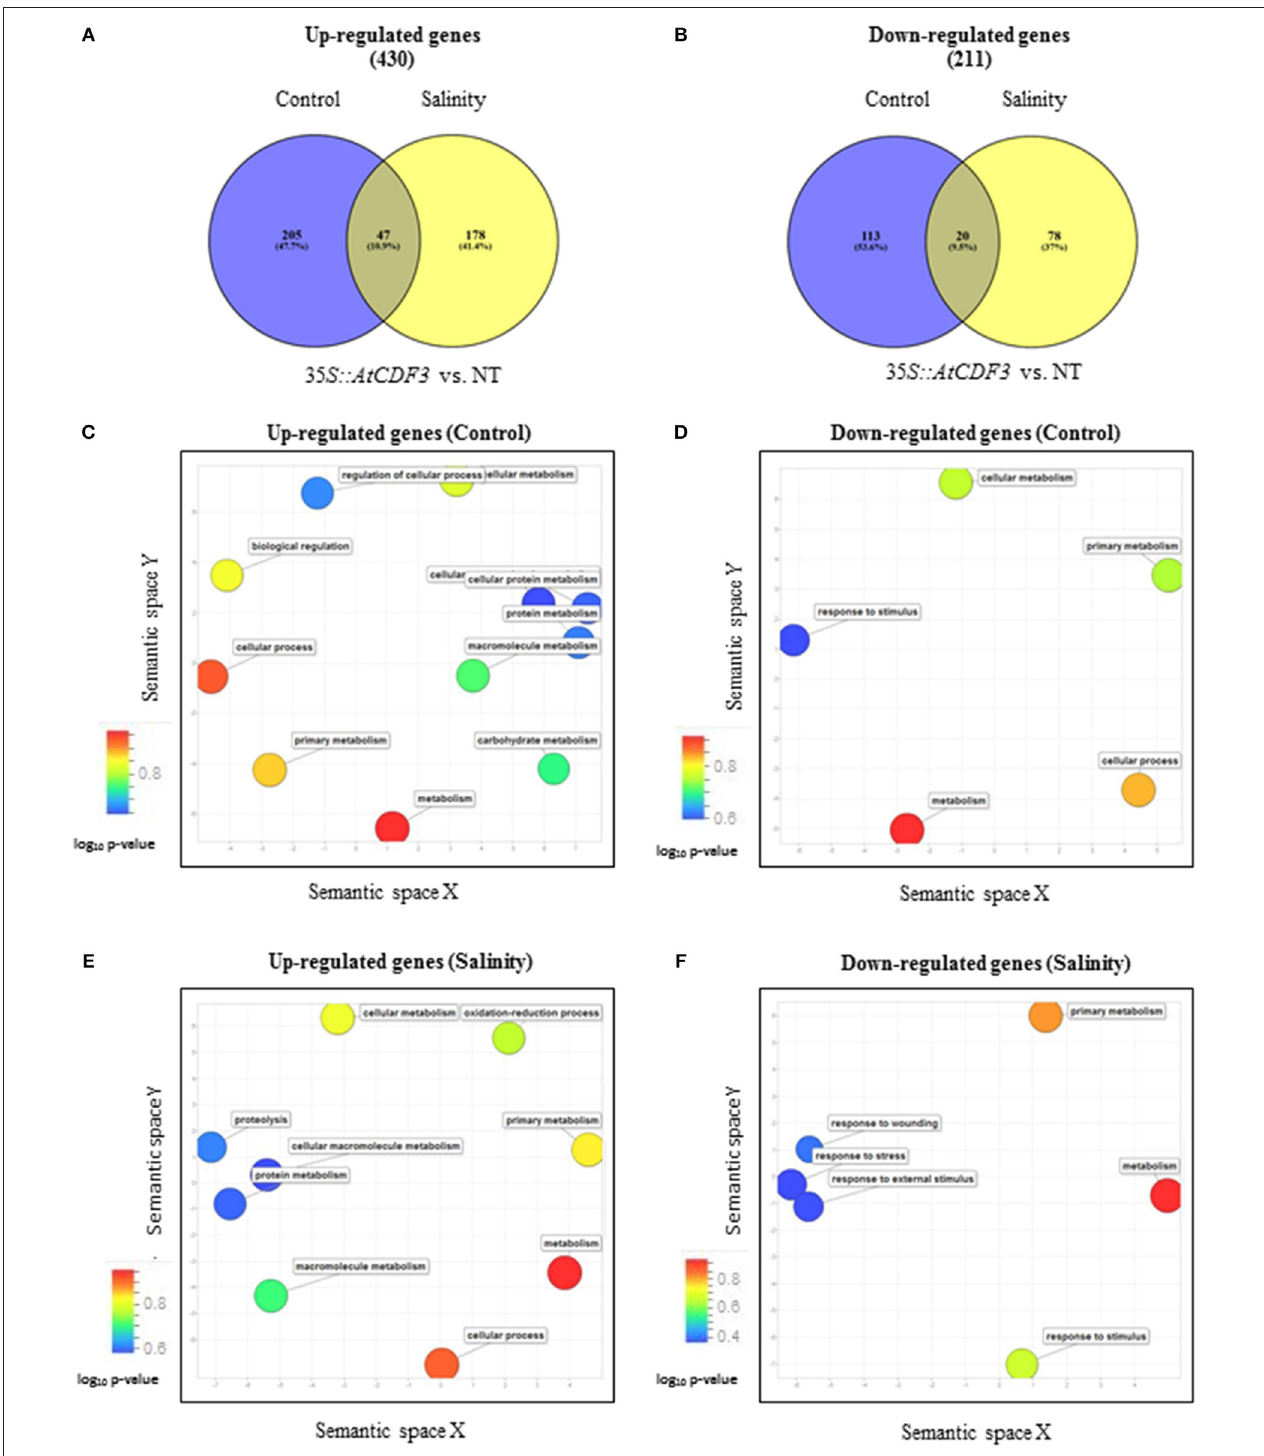
FIGURE 2 | Classification and gene ontology analyses of the genes differentially expressed in the 35S::AtCDF3 plants compared to the NT plants under control and salinity conditions. Thirty-day-old NT and 35S::AtCDF3 plants grown in hydroponic culture were subjected to moderate salinity (75 mM NaCI). Leaf transcriptomic analysis was performed after 15 days. (A,B) Venn diagrams showing the overlap of the up-regulated and down-regulated genes expressed in the 35S::CDF3 transgenic plants vs. the NT plants in response to salinity. (C–F) Scatter plot of the genes significantly ( P < 0.05) up- or down-regulated in the 35S::AtCDF3 plants compared with the non-transformed NT plants under control and salinity conditions. The GO analysis was performed using the AgriGO and Revigo tools. Bubble color indicates the P -value for the false discovery rates derived from the AgriGO analysis as well as biological processes. NT, non-transformed.